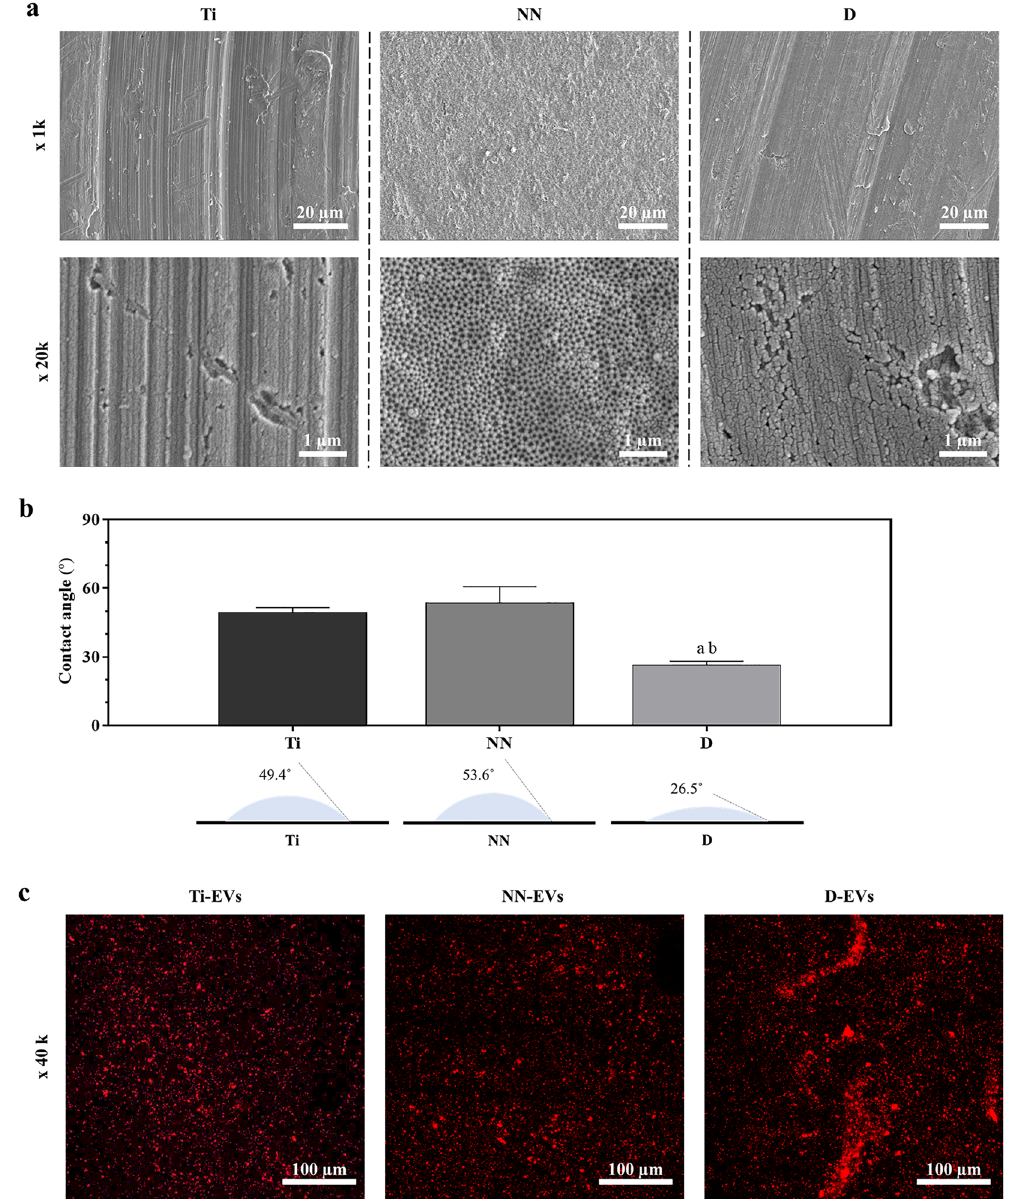
Figure 2. Titanium implant characterization. ( a ) Scaning electron microscopy images of Ti, NN and D surfaces at ×1000 and ×20,000. ( b ) Contact angle for Ti, NN and D surfaces using a 1 µl water drop (n = 3). Values represent the mean ± SEM. Data were compared by ANOVA, using Games-Howell as post hoc. Statistically significant differences were considered for p < 0.05 and represented with a compared to Ti, b compared to NN. ( c ) Confocal laser scanning microscopy images of surfaces functionalized with PKH26 stained pEVs (shown in